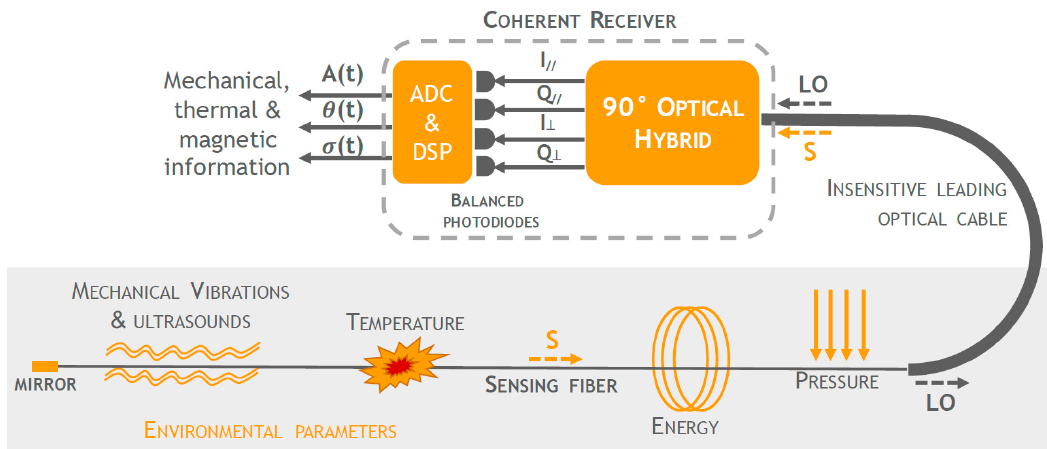
Figure 1. Polarization and phase diversity coherent detection scheme exploiting a 90° optical hybrid.